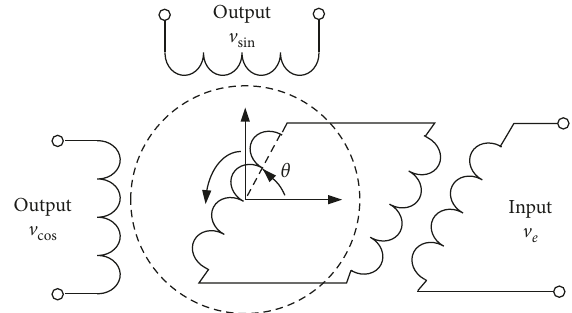
Figure 1: Simplified operation principle diagram of the